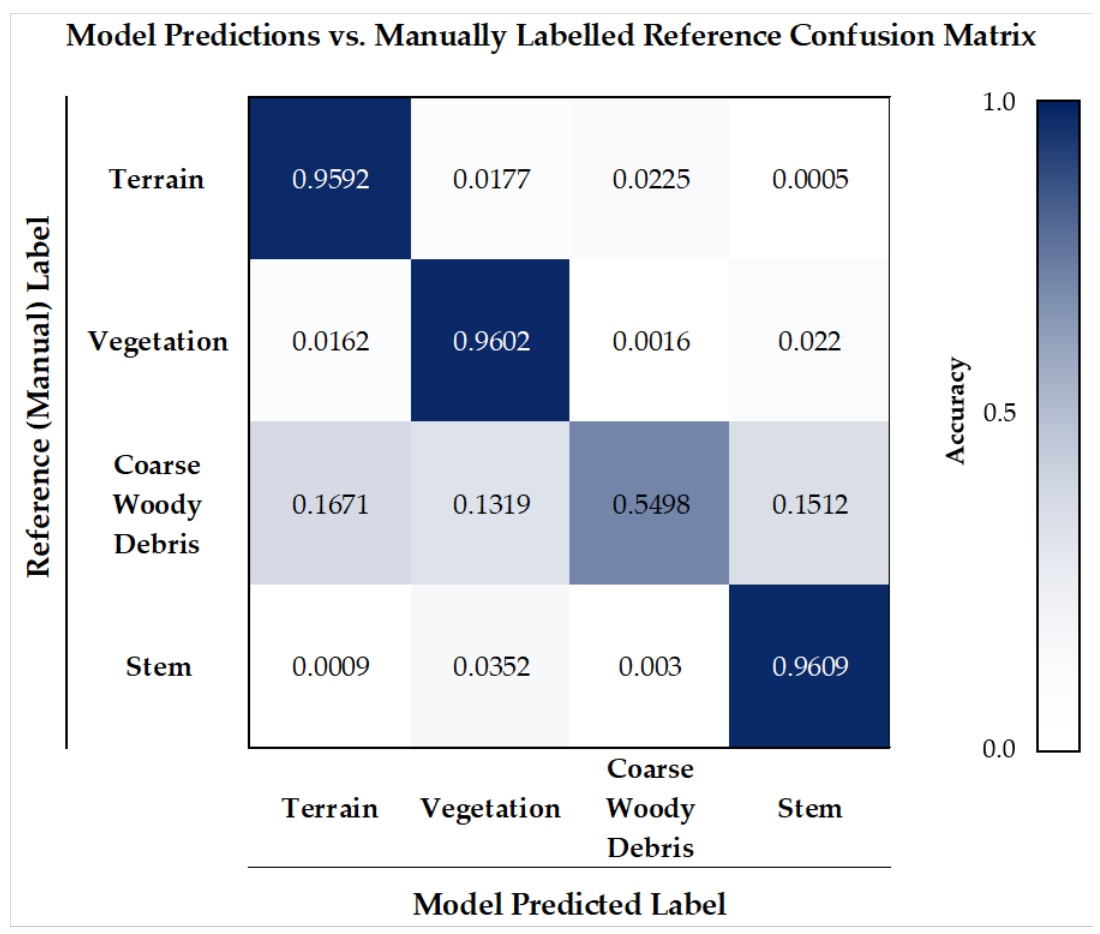
Figure 8. Confusion matrix showing performance of the semantic segmentation process compared against manually segmented points.